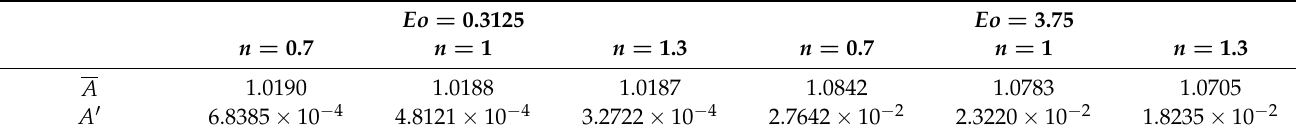
Table 3. Mean A and fluctuation A (cid:48) of the normalized surface area, averaged over all bubbles. Eo = 0.3125 Eo = 3.75 n =